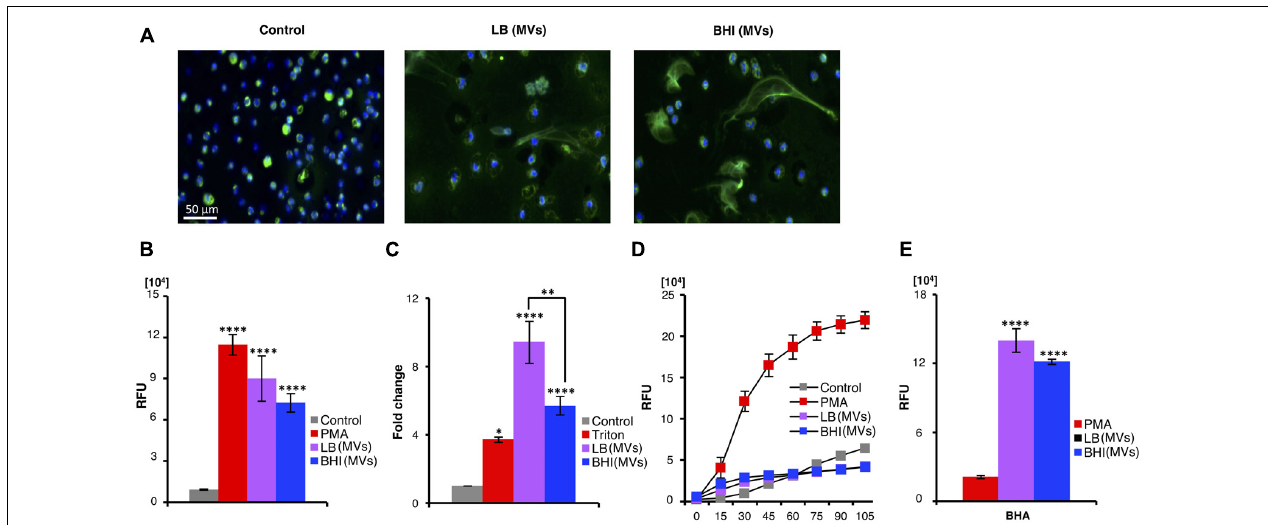
FIGURE 3 | Staphylococcus aureus MVs promote extracellular trap formation in human neutrophils in vitro independent of ROS generation. Neutrophils were incubated with PBS (control) or MVs isolated from bacteria grown in LB or BHI. NET induction was evaluated using various approaches: (A) Immunostaining using a primary antibody against myeloperoxidase (green). The nucleus is stained with Hoechst (blue). Scale bar is shown. (B) Quantification of extracellular DNA and (C) measuring neutrophils degranulation through determining the elastase release. The absorbance at 405 nm in the absence of MVs (control) was normalized to 1, and the absorbance in the presence of MVs (LB and BHI) and the positive control (Triton) is represented as the fold change of elastase release. (D) DCF-based ROS assays were performed to evaluate the effect of S. aureus MSSA476 MVs on ROS production by neutrophils. (E) Neutrophils were pre-treated with the ROS scavenger BHA for 30 min before addition of either PMA or MSSA476 MVs to determine whether MVs induced NET production. Data represent as the mean ± SEM of at least three independent experiments. The significance is indicated by asterisks ( ∗ ): ∗∗ P ≤ 0.01; ∗∗∗ P ≤ 0.001; ∗∗∗∗ P ≤